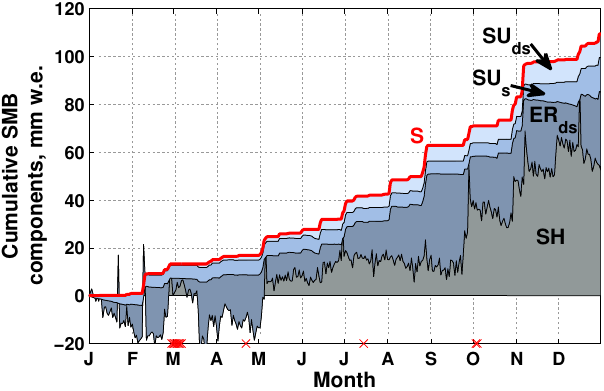
Figure 9. Cumulative daily surface mass balance (SMB) compo- nents during 2012: snowfall ( S ), surface sublimation (SU s ), drifting snow sublimation (SU ds ), drifting snow erosion (ER ds ), and mea- sured snow height changes since 1 January 2012 (SH) (Sect. 4.2.4). SU s and SU ds are plotted as ablation terms. ER ds is calculated and plotted as a residual term: ER ds = S − SU ds − SU s − SH. Red crosses at the bottom indicate days of missing MRR data. Letters on x axis mark the first day of each